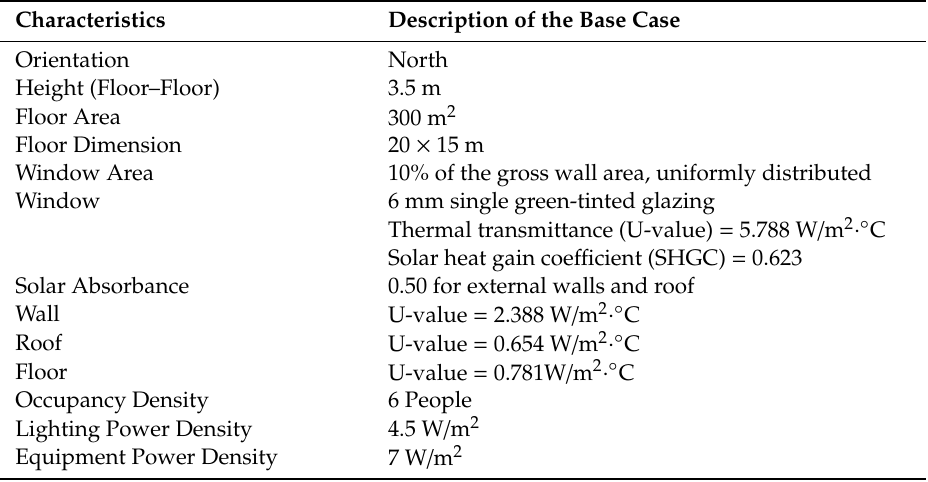
Table 1. Building characteristics and type of systems.